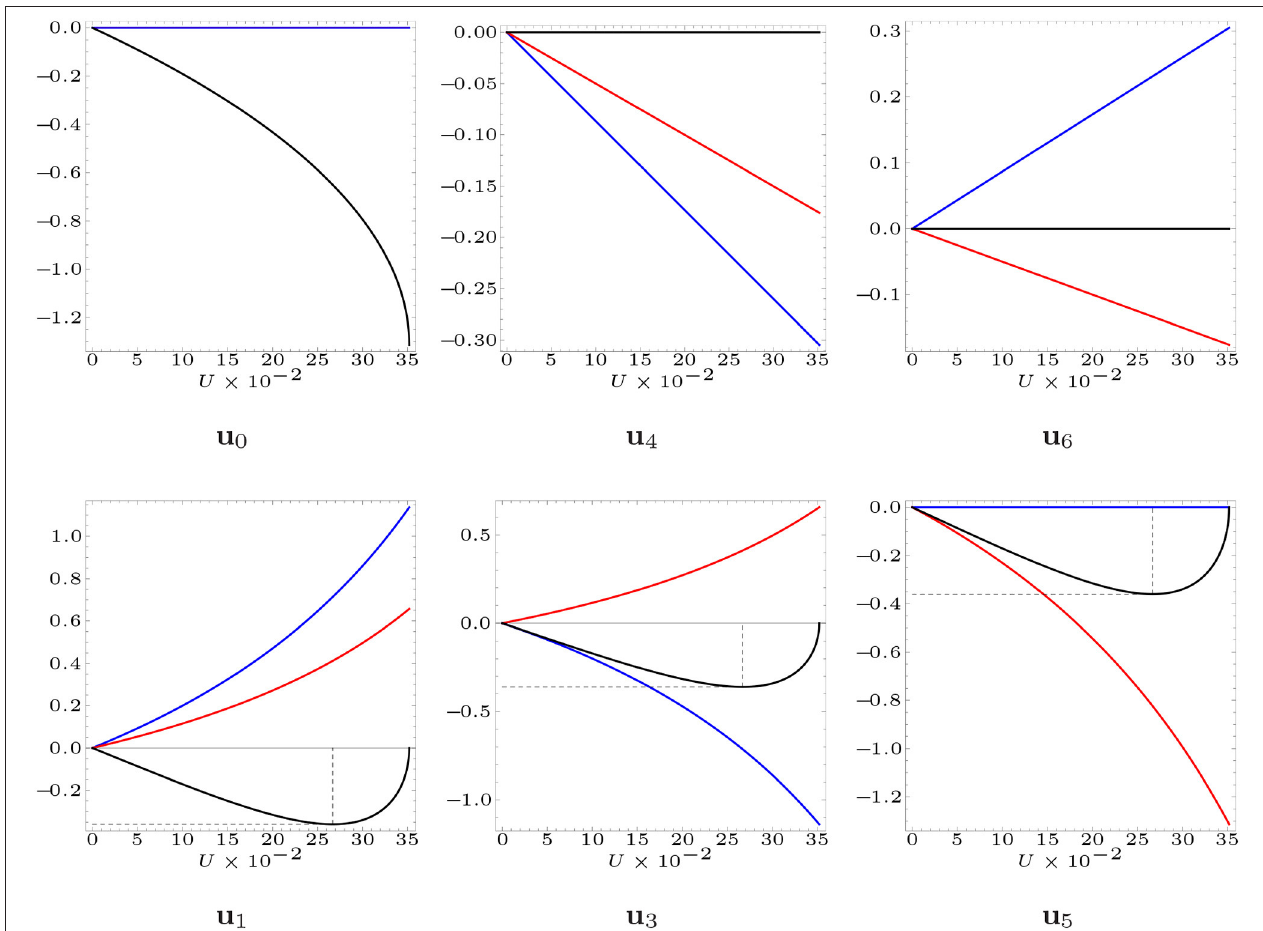
4.55 m. The Cartesian =